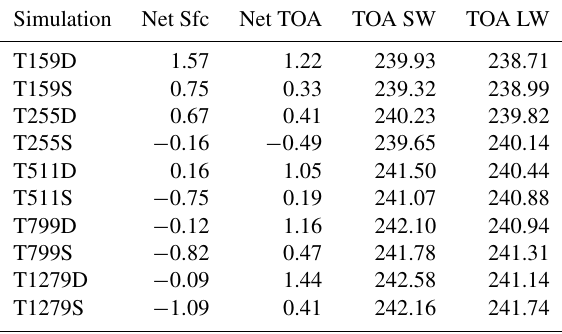
Sfc: surface; TOA: top of the atmosphere; SW: shortwave; LW: